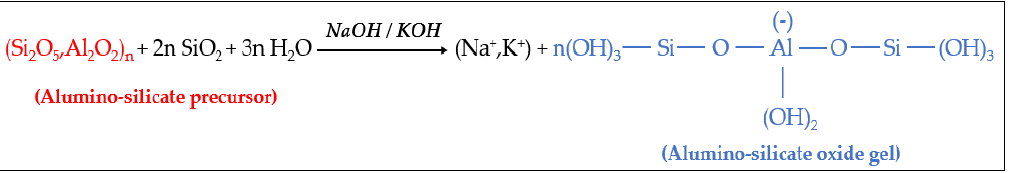
Figure 3. Polycondensation of hydrolyzed aluminate and silicate species and formation of 3D geopolymer network.